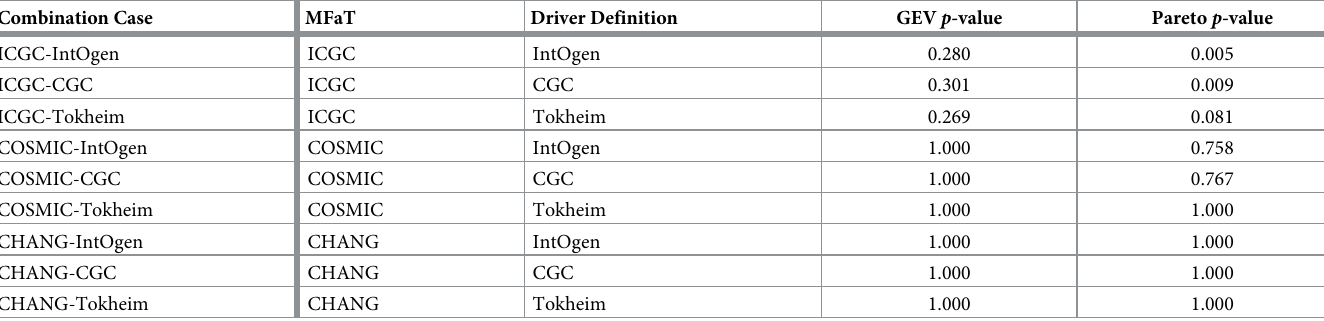
Table 1. The χ 2 goodness-of-fit test p -values of total tumors with symbol -based filtering (rank < 200).